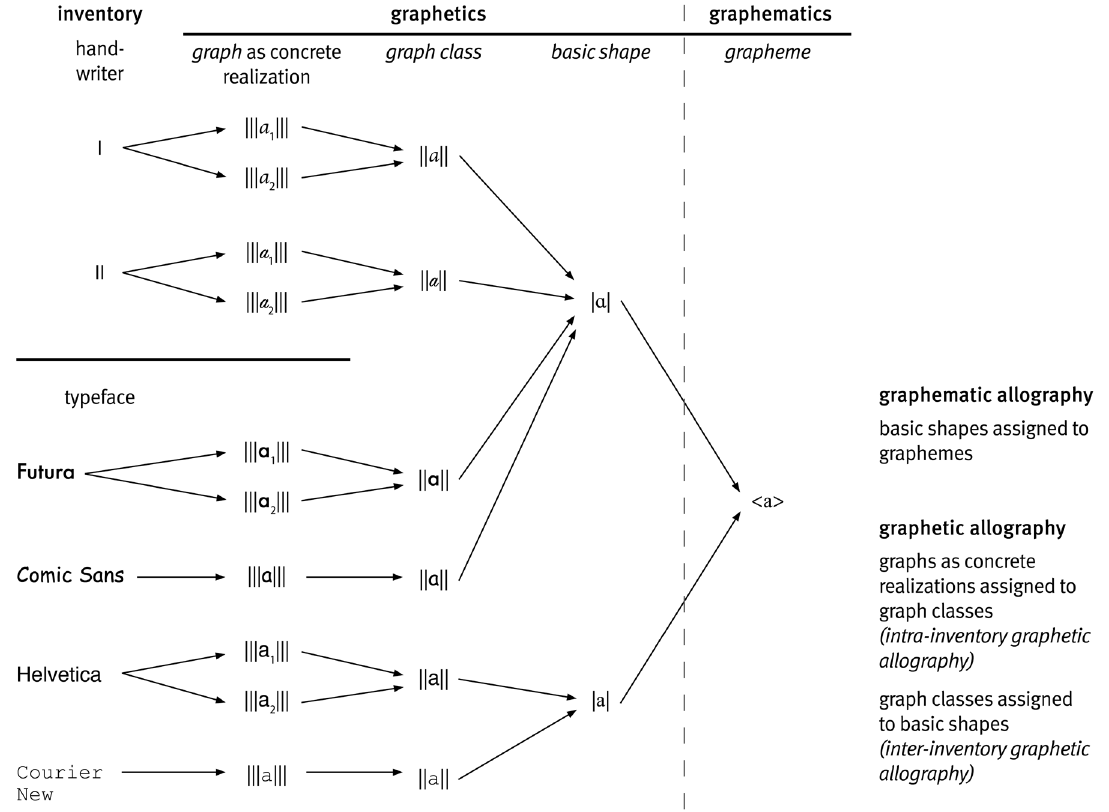
Figure 3: Overview of type - token - relationships in